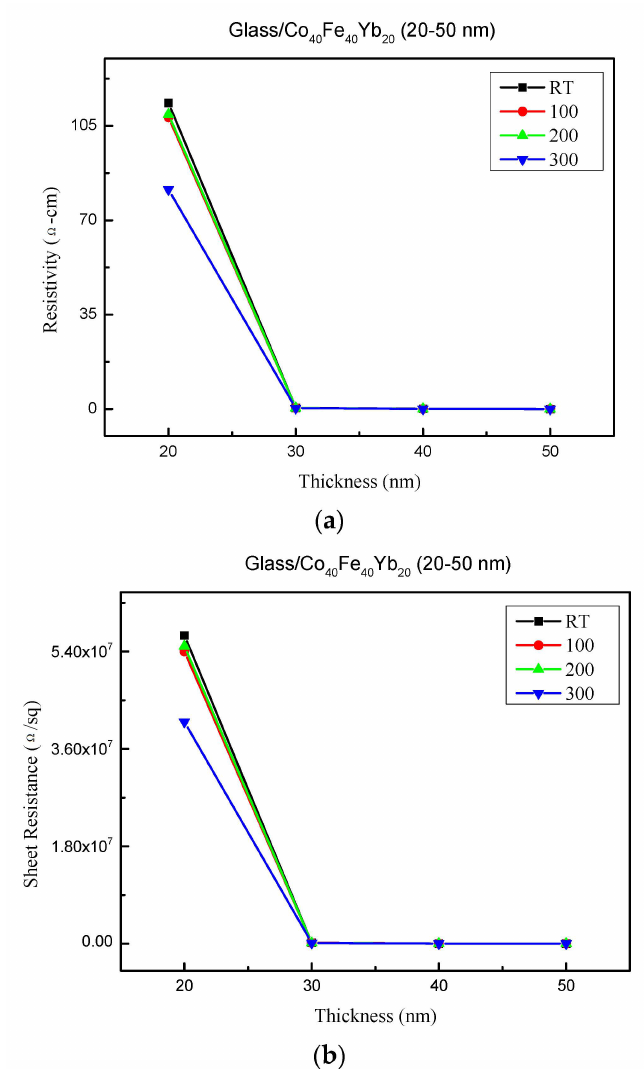
Figure 5. ( a ) Resistivity of Co 40 Fe 40 Yb 20 thin films. ( b ) Sheet resistance of Co 40 Fe 40 Yb 20 thin